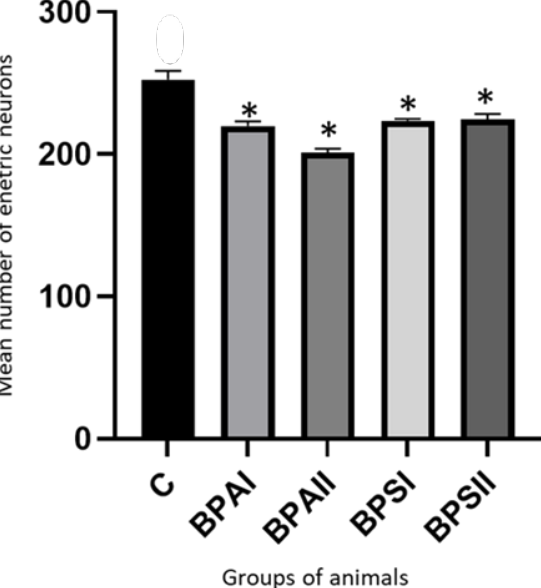
Figure 6. Mean number of enteric neurons ( ± SEM) counted in 50 SmP ganglia in control animals (C), after administration of BPA in low (BPA I) and high dose (BPAII) and after administration of BPS in low (BPSI) and high (BPSII) dose. Statistically significant differences between particular groups of animals and control group are marked with *.